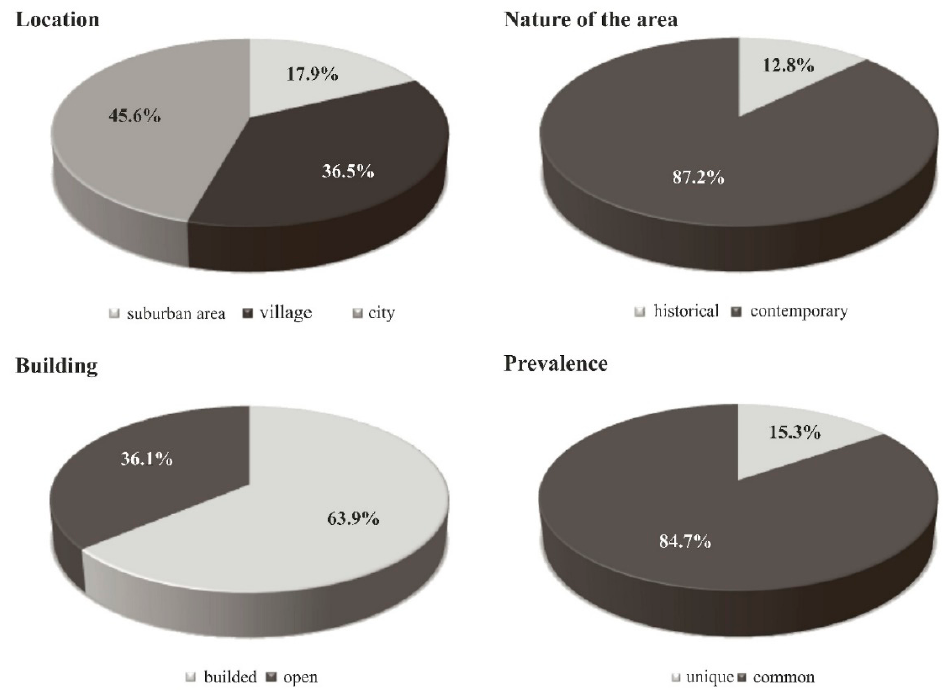
Figure 2. Characteristics of the degraded landscape selected for description by the students (EnvEng and CivEng students combined, n = 244).